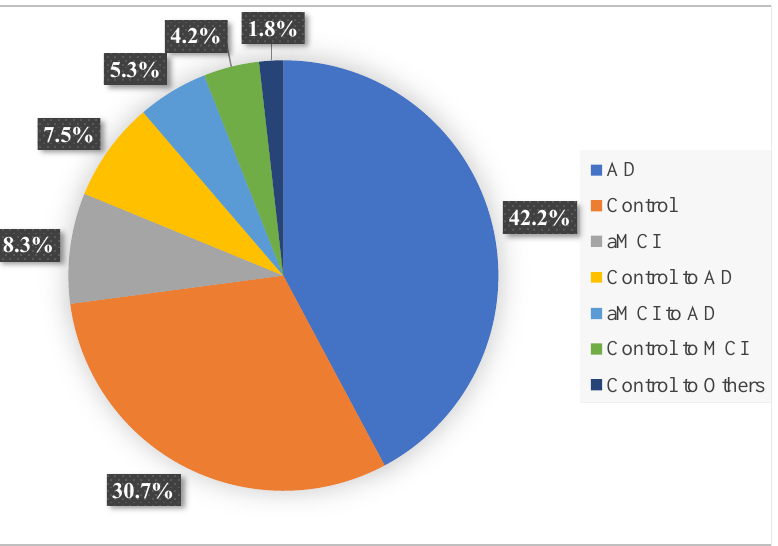
Figure 1 . Percentages of the sample in each diagnostic category. Figure 1. Percentages of the sample in each diagnostic